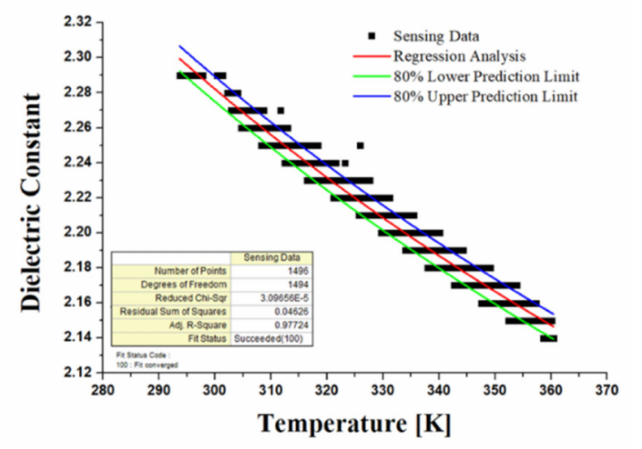
Figure 6. The correlation between dielectric constant and temperature using the Debye model.